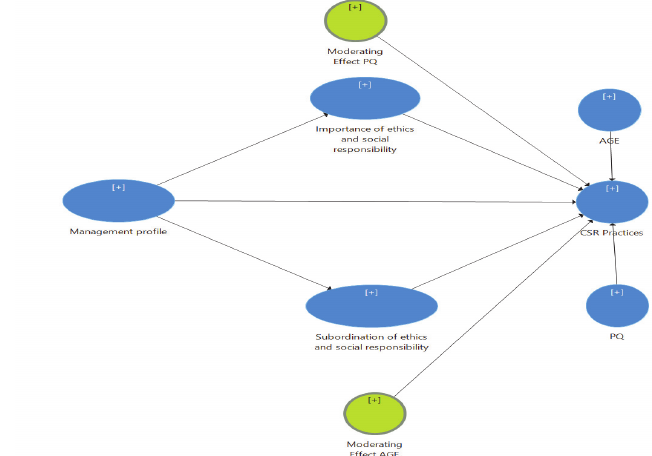
Fig. 3 . The model examines the moderate role of CEO’s age and professional qualifications Hypothesis test results by Smart PLS model through bootstrap technique are as follows: